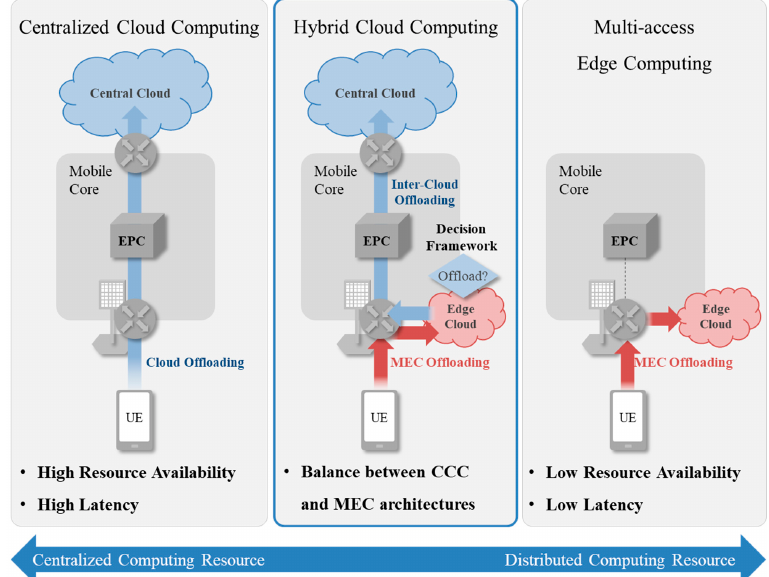
Figure 3. Three network communication architectures proposed for the analysis.